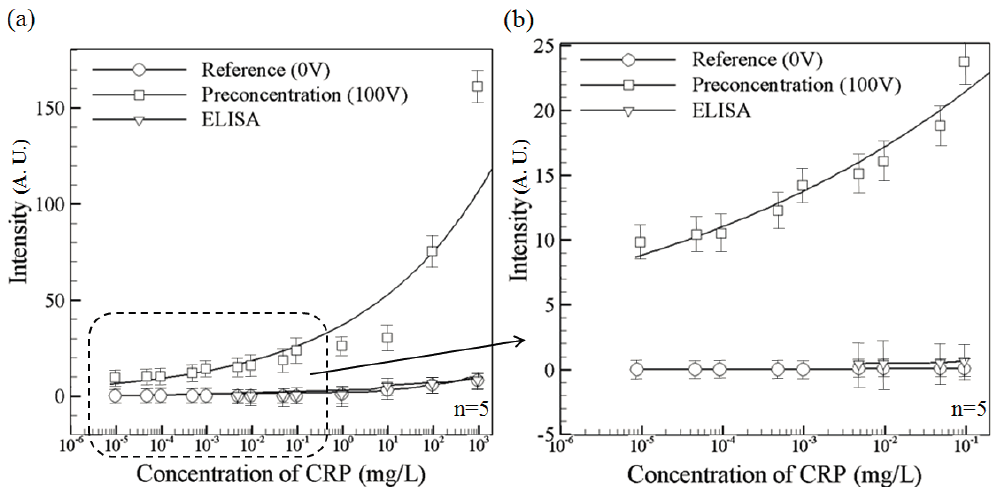
Figure 5. Variation of the concentrated CRP fluorescence intensity with various initial CRP contentrations in the proposed nano-microfluidic chip and ELISA device: ( a ) Intensity variation over full CRP concentration range; and ( b ) Expanded view of intensity variation over partial CRP concentration range. The present chip permits CRP detection to be performed at initial concentrations as low as 9.5 × 10 − 6 mg/L, whilethe ELISA system is unable to detect the concentrations lower than 4.76 × 10 − 3 mg/L . Data points represent the mean of five measurements, and the error bars represent one standard deviation from the mean.